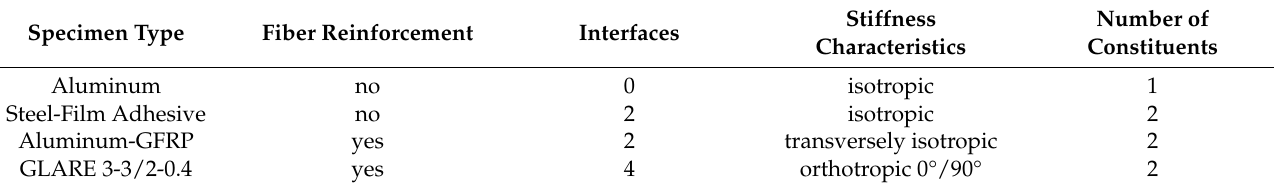
Table 1. Overview of the selected specimens and their structural